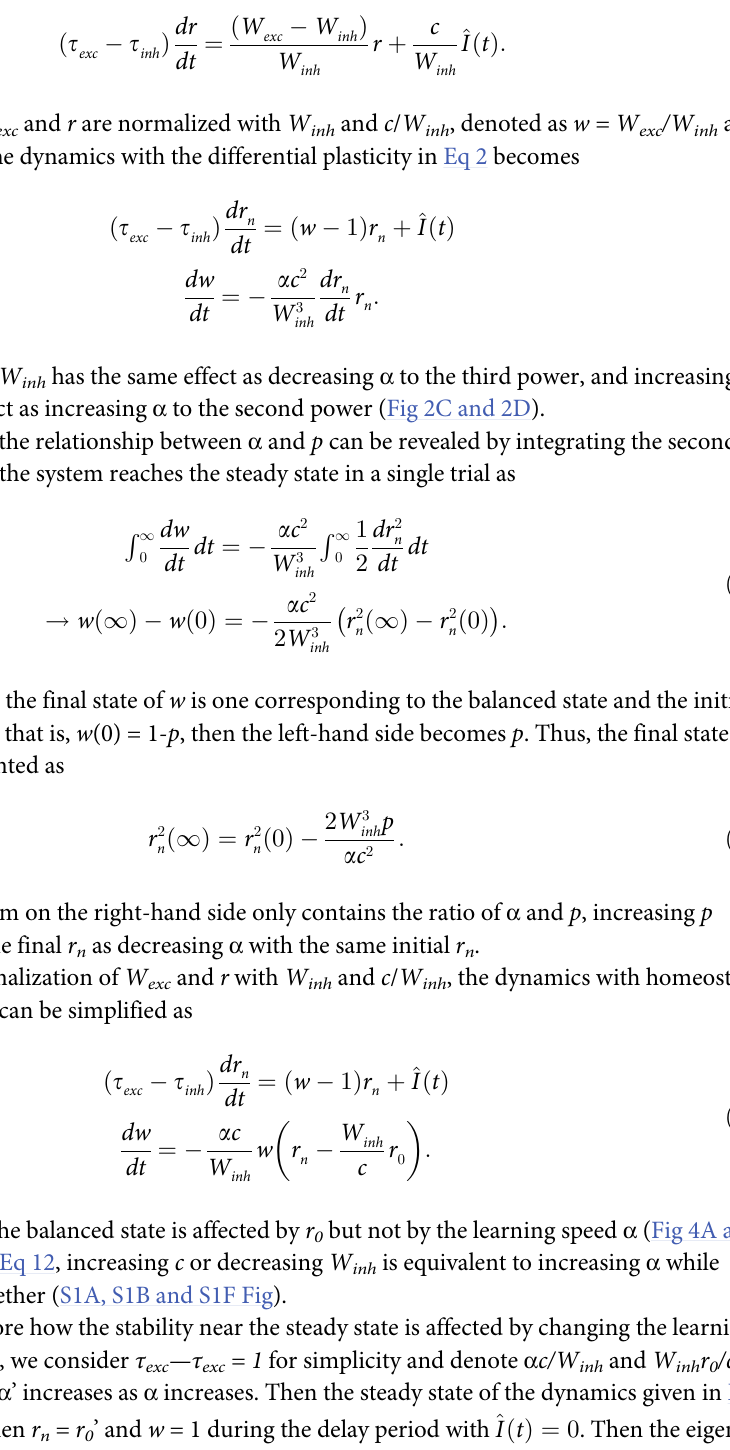
. The imaginary part of